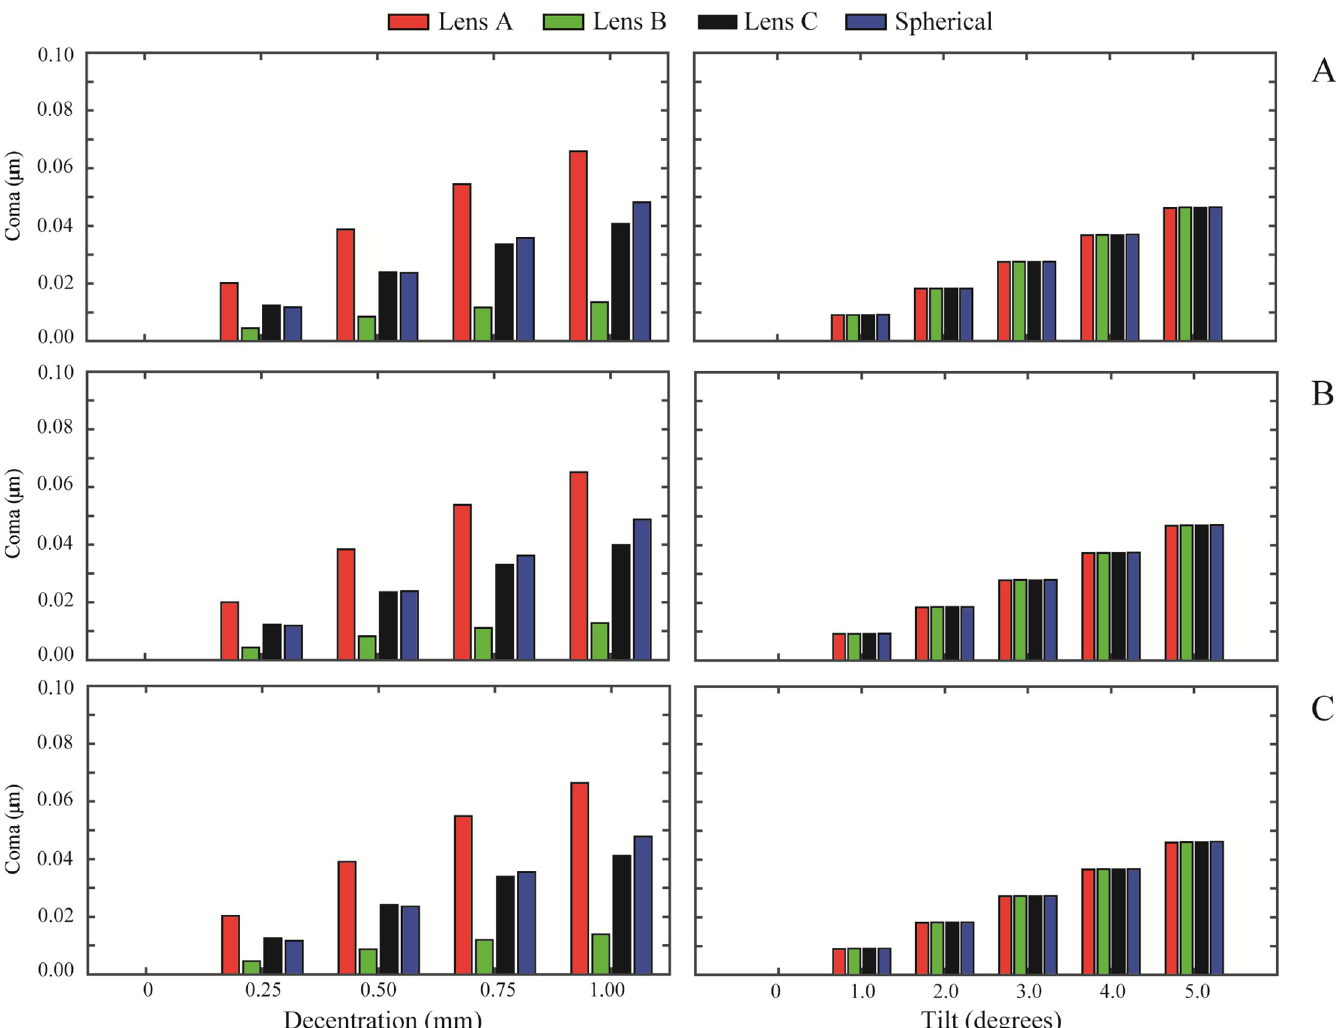
Fig 4. RMS coma ( Z (cid:0) 1 and Z 1 ) values of the designed IOLs for misalignment (left column) and tilt (right column) with each different cornea: A) Normal, B) Myopic, C) 3 3 Hyperopic.